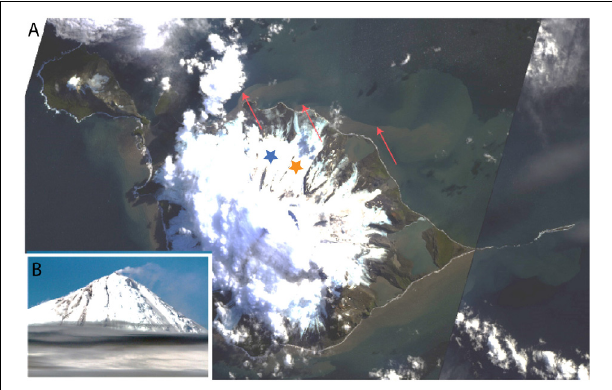
FIGURE 2 | Landsat 8 satellite image of Heard Island (A) with image of Mawson Peak, Heard Island, taken during the HEOBI voyage inset (B) . Sharp delineation can be seen between the outflowing, sediment laden, fluvial/subglacial meltwater on the north–east side of the island and the surrounding ocean. To the north of the island, outflow can be seen originating at the beginning of each major glacier terminus. Due to the east–north–east flowing surface currents, sediments are concentrated against the coastline on the south–west of the island, making outflow less obvious. Downes (blue star) and Ealey (orange star) marine terminating glaciers are shown. Red arrows indicate delineation between outflowing glacial water and seawater. Source satellite image: Google Earth (earth.google.com/web/), inset picture credit Pete Harmsen (Marine National